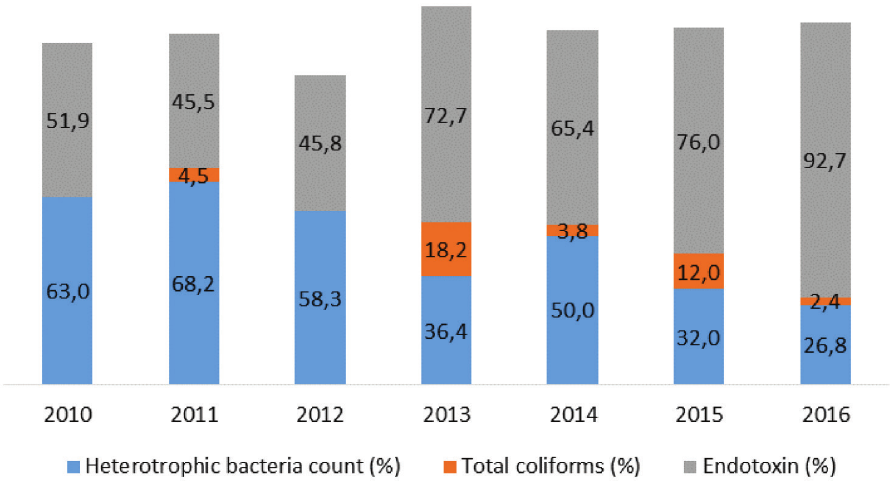
FIGURE 4 – Profile of unsatisfactory results for the first water sample collection in dialysis units located in São Paulo State, Brazil, from 2010 to